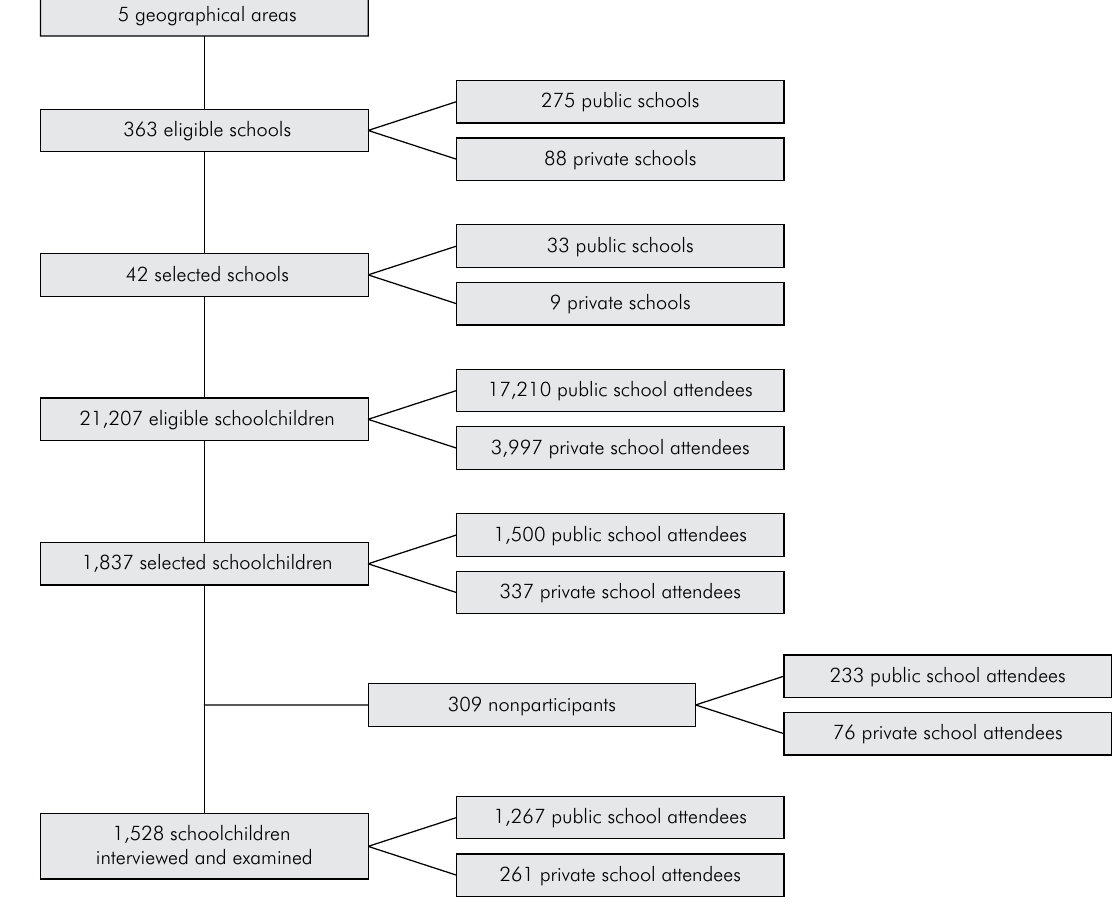
Figure. Flowchart of the